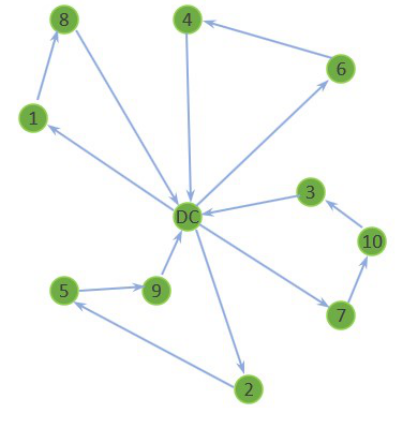
Fig. 7. A delivery tour (200 kg vehicle capacity) Table 6. The example of changing the vehicle